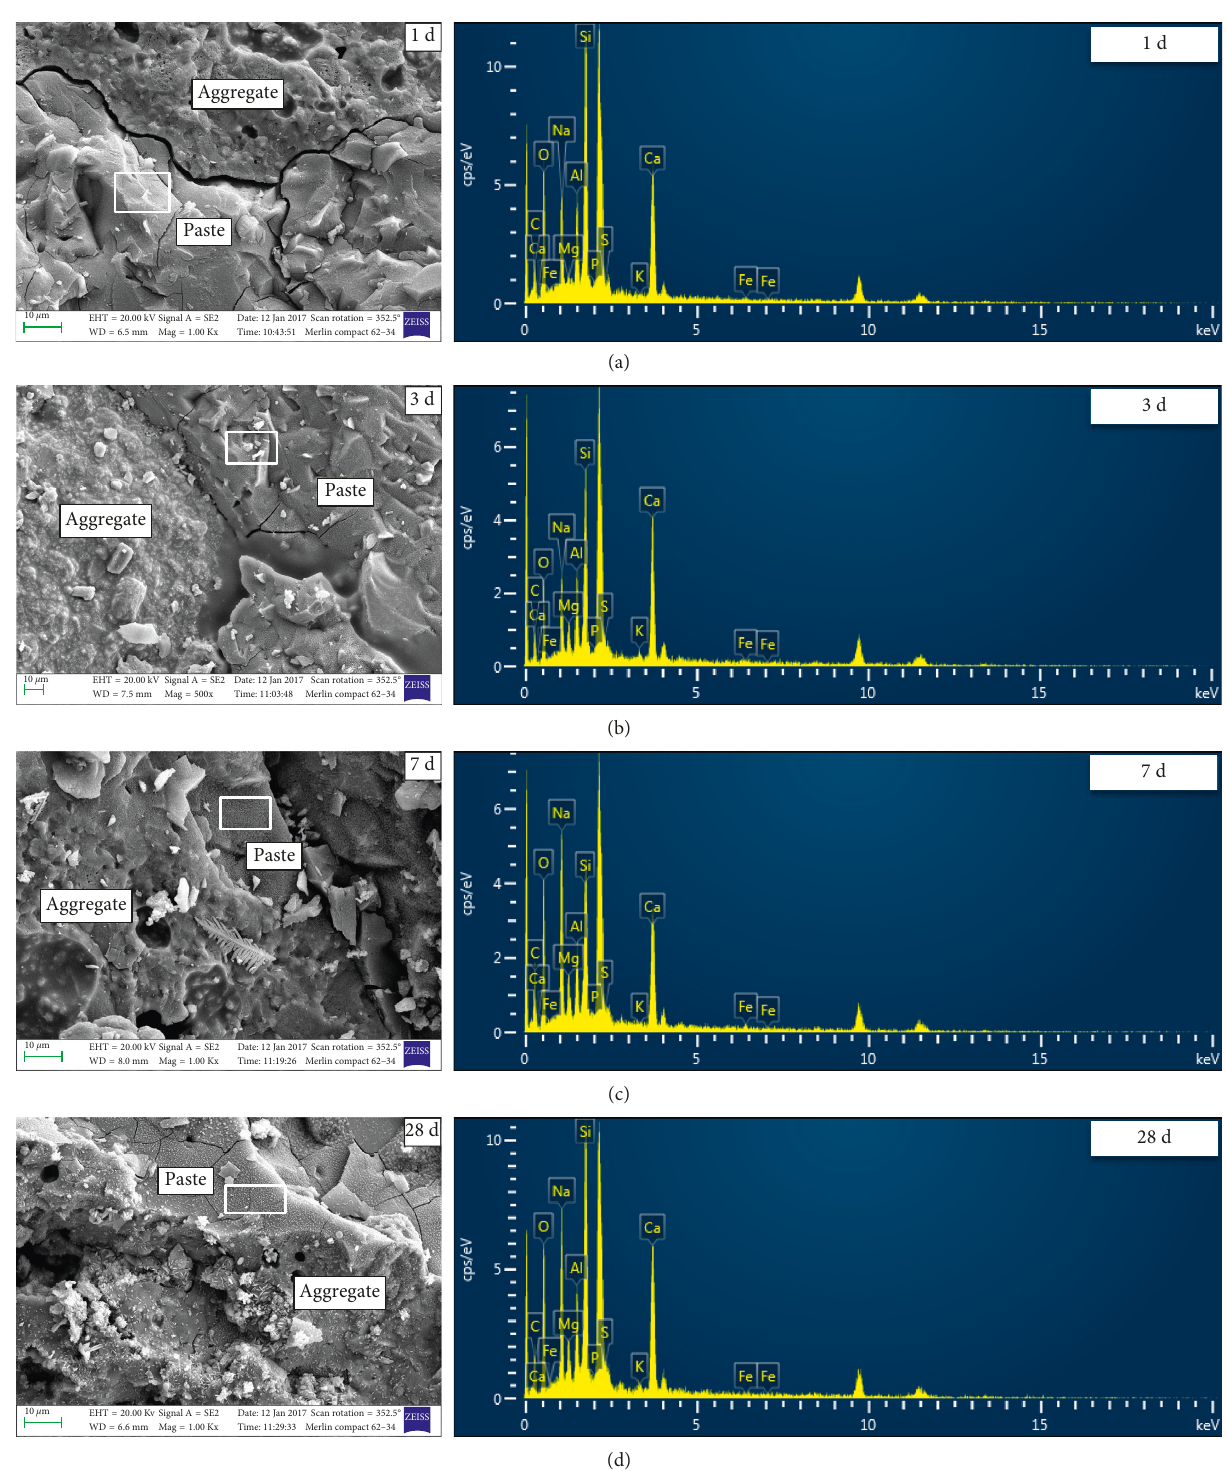
Figure 10: SEM/EDS of AAS mortars incorporated 8% Na